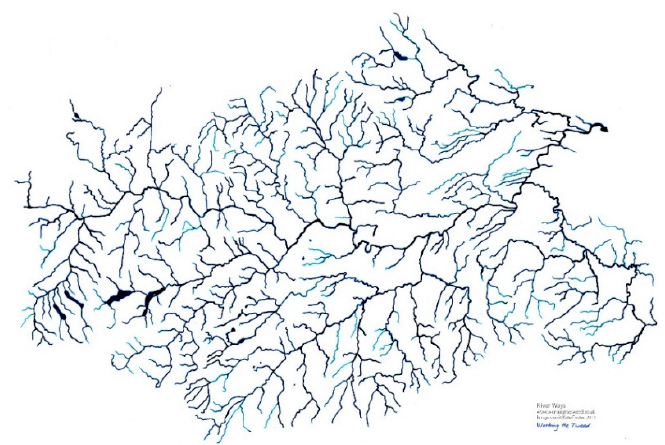
Figure 7. River Ways , from ‘Working the Tweed’. Image permission of Kate Foster.